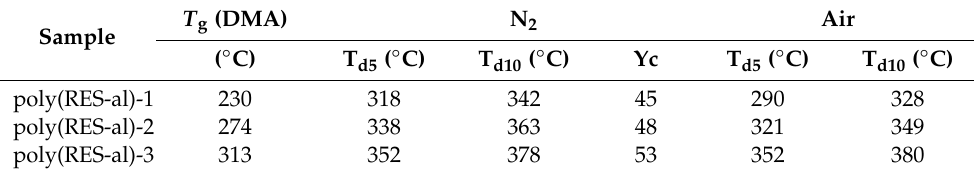
Figure 9. Thermogravimetric analysis of RES-al based thermosets in air. Table 1. Thermal properties of RES-al based thermosets.